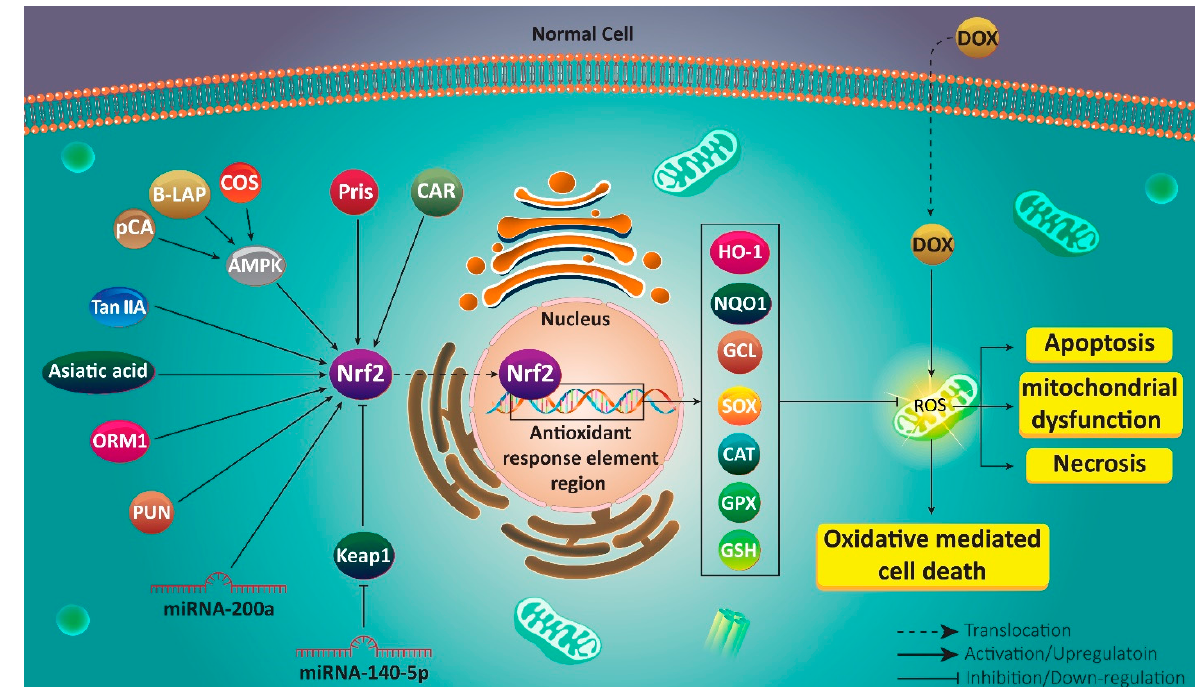
Figure 2. Targeting Nrf2 signaling pathway in chemoprotection. Regulation of Nrf2 signaling by upstream mediators and protective compounds in decreasing adverse effects of doxorubicin. Apoptosis, mitochondrial dysfunction, necrosis and cell death are prevented upon Nrf2 activation. Table 1. Nrf2 signaling as a chemoprotection mechanism.